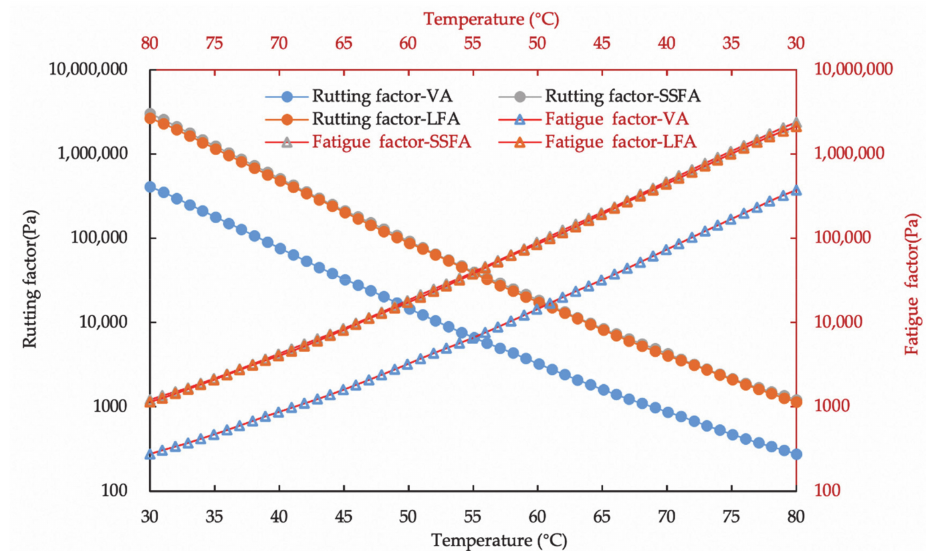
Figure 6. Rutting factor and fatigue factor of VA, SSFA and LFA.